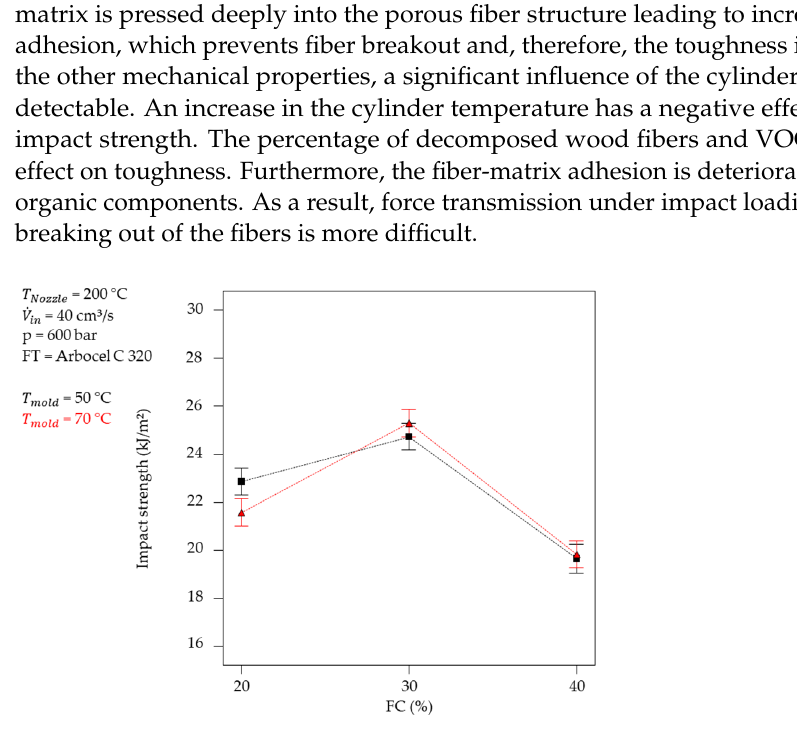
Table 5. p -values of various test parameters for Shore hardness. p -Value